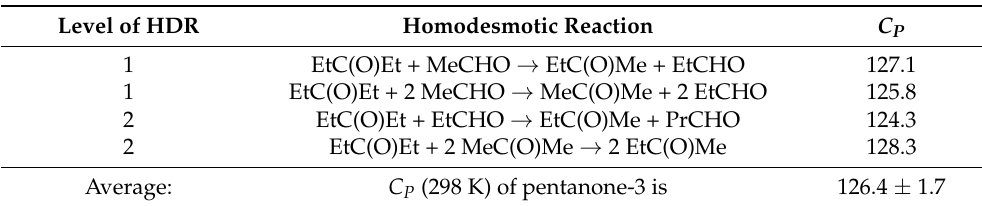
Table 2. CS HDR estimation of the gas-phase isobaric molar heat capacity of pentanone-3, J/mol · K, 298 K 1